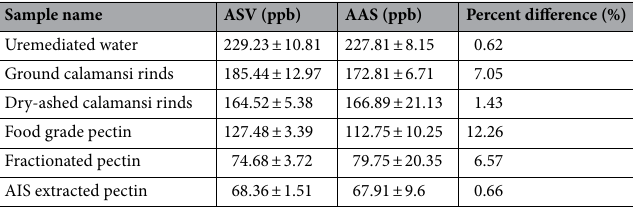
Table 1. Comparison of detected Pb concentration in ASV and AAS.